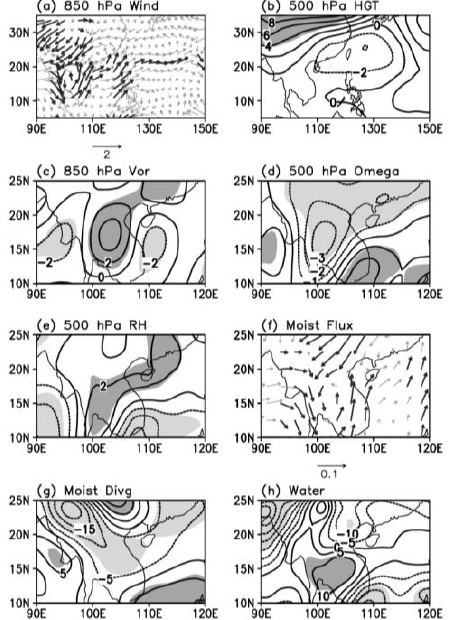
Figure 4. Epochal differences (2002–1994 minus 1982–1993) in (a) 850 hPa wind (m s −1 ), (b) 500 hPa geopotential height (gpm), (c) 850 hPa vorticity (contours 10 -6 s -1 ), (d) 500 hPa vertical pressure velocity (Pa s -1 ), (e) 500 hPa relative humidity (%), (f) moisture flux (g m −1 s −1 ), (g) moisture flux divergence (10 −7 g m −2 s −1 ) and (h) atmospheric precipitable water (10 −2 g m −2 ). Values exceeding the 95% confidence level are